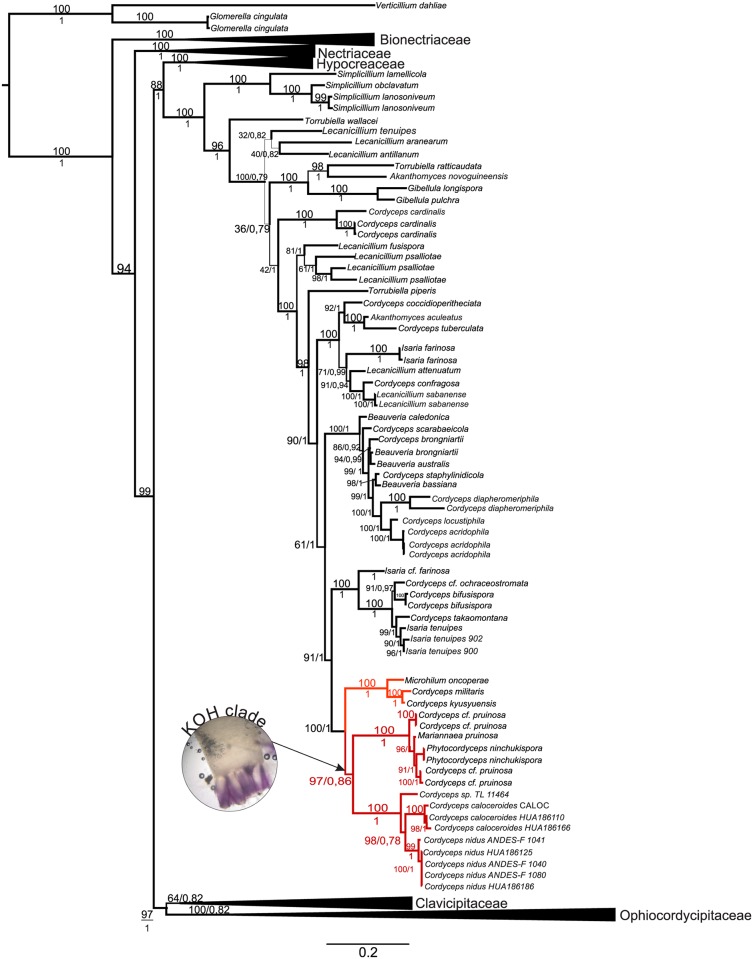
Phylogenetic relationships inferred from a Maximum Likelihood analysis of Cordyceps species which parasitize spiders.Combined data set of SSU, LSU, TEF, RPB1, and RPB2 nuclear loci. Sequences from Verticillium dahlie and Glomerella cingulata were used as outgroups. Numbers above branches indicate Bootstrap support (BS) and below posterior probability support in Bayesian analyses (PP). Bionectriaceae, Nectriaceae, Hypocreaceae, Clavicipitaceae, Ophiocordycipitaceae are collapsed to emphasize of Cordycipitaceae.